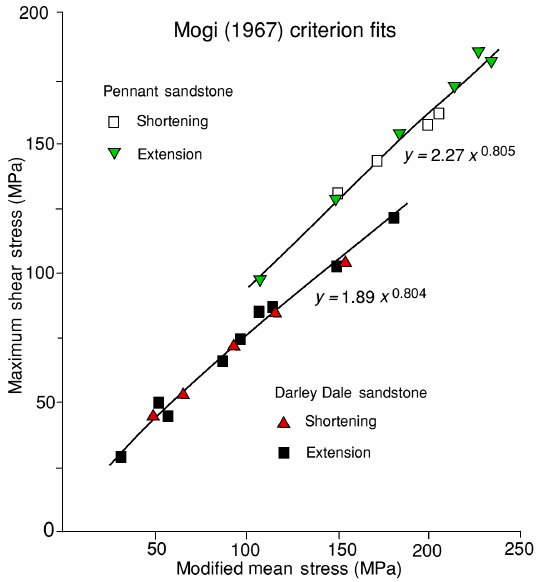
Figure 11. Fits to failure data for Pennant and Darley Dale sand- stones for β values that bring the shortening and extensional data onto common curves. Maximum shear stress = ( σ 1 − σ 3 )/ 2 and modified mean stress = ( σ 1 + βσ 2 + σ 3 )/ 2. β for Pennant sandstone is 0.09 and for Darley Dale sandstone is